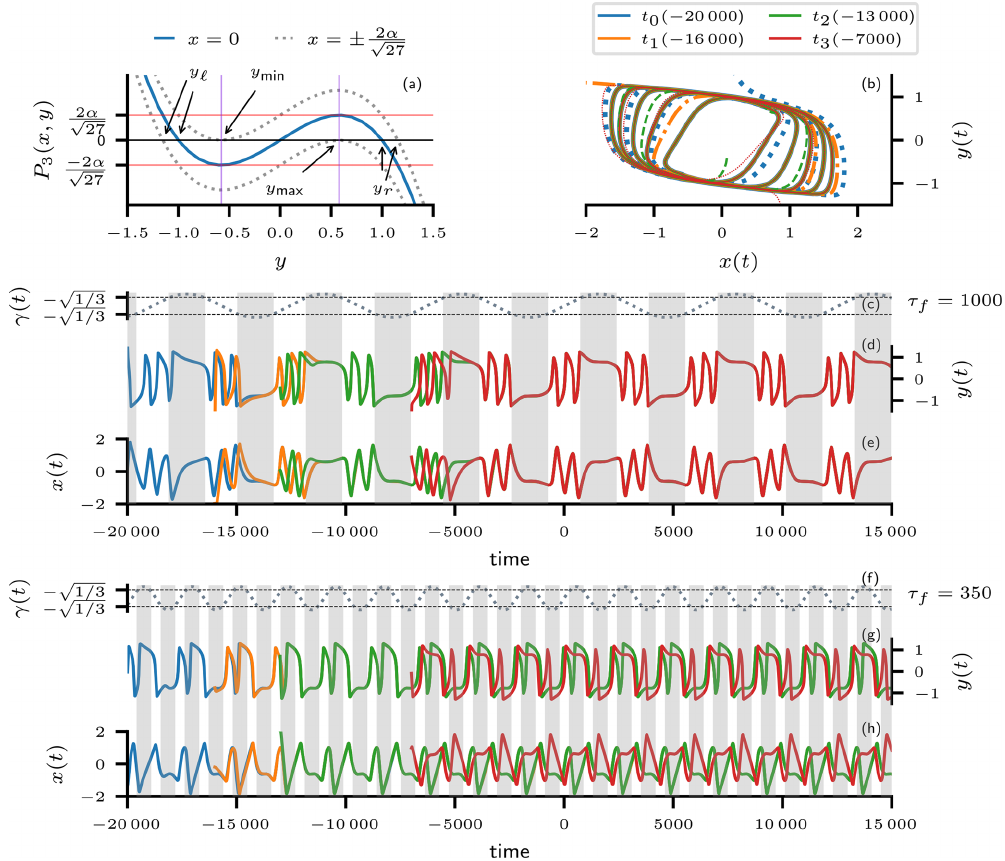
Figure 10. FitzHugh–Nagumo (FHN) model with parameters τ x = 100, τ y = 60, and α = 2. (a) The cubic polynomial P 3 ( x,y ) of the fast derivative as a function of y for x = 0 (solid blue line); the red lines point to the local maximal and minimal values of P 3 ( x,y ), namely √ ± 2 a/ 27, respectively – these are the maximal values by which P 3 can be shifted up or down, while maintaining all of its three roots; √ the dotted gray lines indicate the shifted function with x = ± 2 α/ 27. The purple lines labeled y min and y max mark the right and left boundaries for the roots y l and y r , respectively: y l and y r can never be located in between the two purple lines. (b) Trajectories of the non- autonomous model with γ ( t ) = 0 . 8sin( t/τ f ) and τ f = 1000, plotted in the ( x,y ) phase plane; the trajectories are colored by their starting times { t 0 = − 20000 , t 1 = − 16000 ,t 2 = − 13000 ,t 3 = − 7000 } , and the initial positions were drawn from a standard Gaussian bivariate distribution. (c) The slow time-dependent forcing γ ( t ) = 0 . 8sin( t/ 1000). (d, e) The same trajectories as in (b) but plotted in time as y = y ( t ) and x = x ( t ), respectively. Panels (f–h) are same as panels (c) – (e) but for the fast time-dependent forcing γ ( t ) = 0 . 8sin( t/ 350). The gray √ shading in panels (c) – (h) indicates intervals during which | γ | > 1 / 3, and the internal oscillation is hence